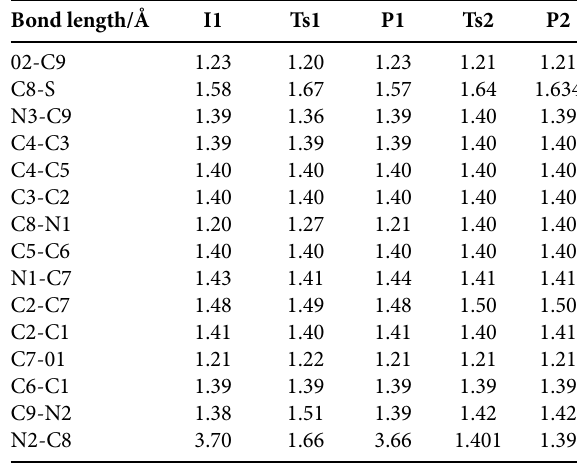
Figure 2. Structure of I1 with enlarged numbering for clarity . Table 2. Compiled results from the computation of the reaction mechanism using the B3PW91/6-31G(d), M06/6-31G(d) and Wb97XD/6-31G(d) functionals and basis set. Species Dipole Imaginery Free Change in Change